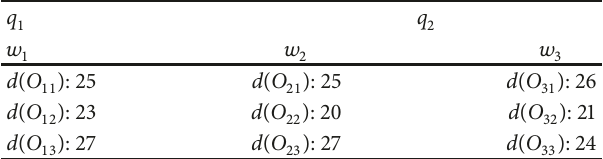
Table 2: Processing time of operations for the FMS in Example